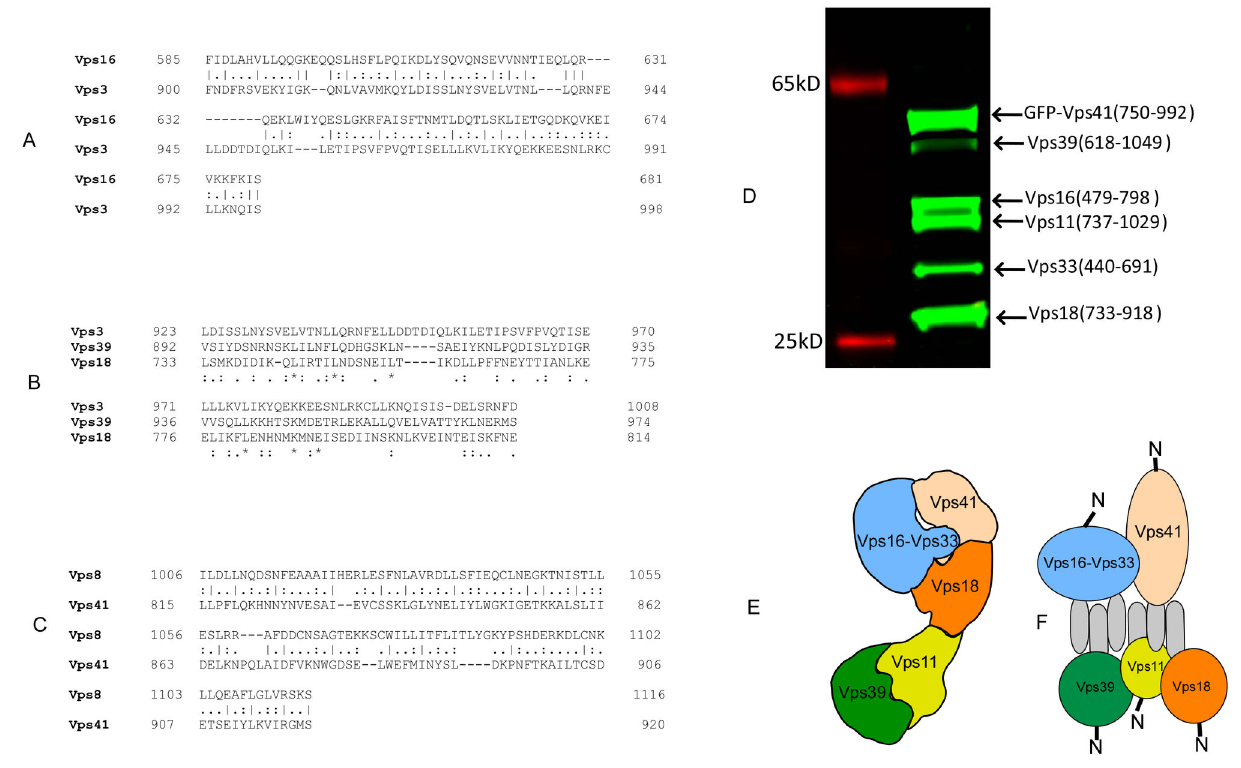
Figure 4. Analysis of HOPS/CORVET complex assembly domains (A) sequence alignment of VPS11 interacting domains of Vps3 and Vps16. (B) Multiple sequence analysis of the complex assembly domains of Vps3, Vps16 and Vps39. (C) Sequence alignment of the Vps8 and Vps41 interacting domains. (D) Reconstitution of the interaction core of HOPS complex. The truncated subunits we co-expressed with GFP-tagged Vps41 subunit and isolated on the anti-GFP matrix as described above. (E) Organization of HOPS complex based on the low resolution structure of yeast produced complex [13]. (F) Proposed mode of complex assembly based of the EM reconstruction and the presented biochemical results. doi: